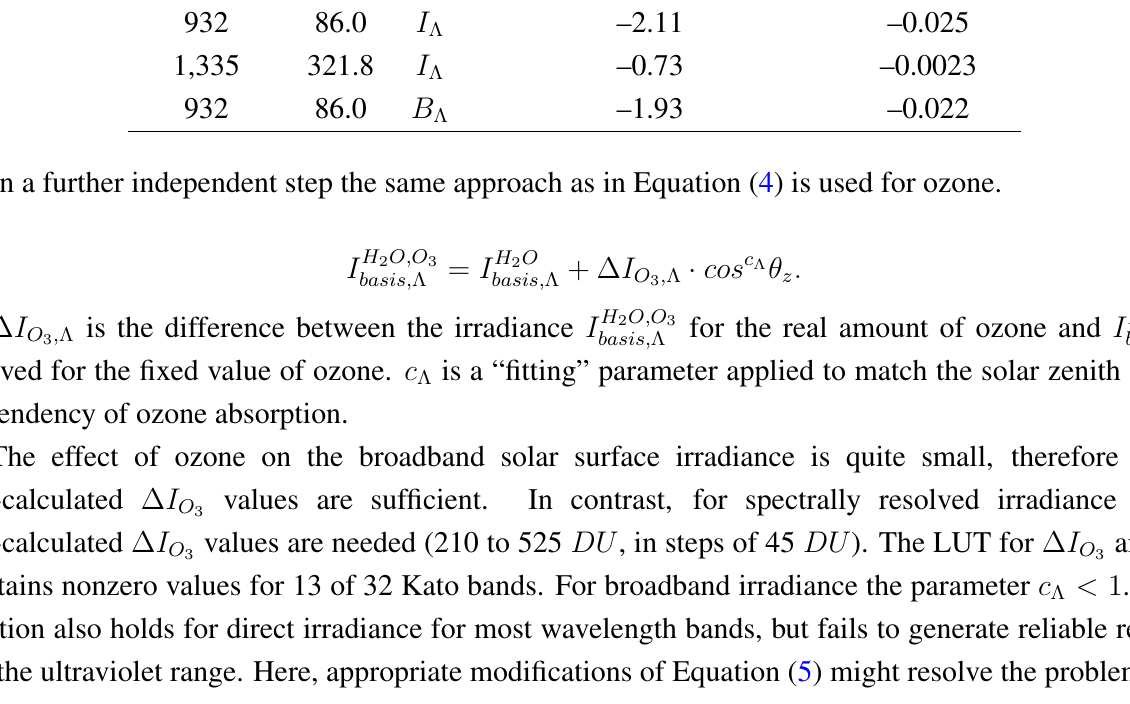
and I H 2 O estimated by explicit RTM calculations basis, (cid:3) basis, (cid:3)